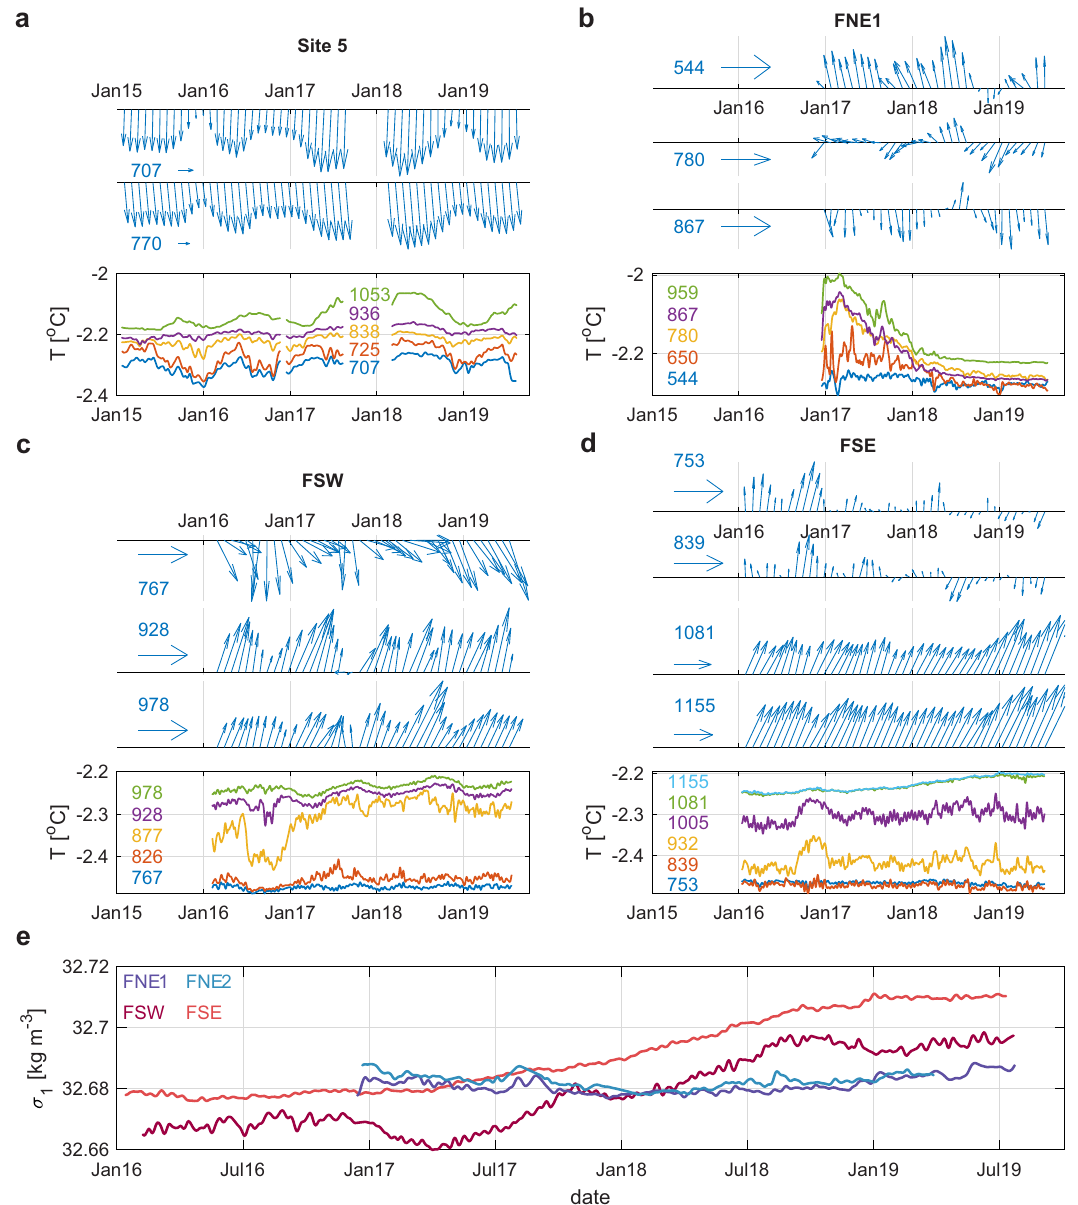
Fig. 4 Overview of ice shelf mooring observations. Time series of low-pass fi ltered velocity vectors (blue arrows) and in situ temperature (colored curves) at ( a ) Site 5, ( b ) FNE1, ( c ) FSW, and ( d ) FSE. Colored numbers indicate the instrument deployment pressure (dbar), horizontal arrows indicate an eastward current of 5 cm s − 1 as a reference scale for the respective axes. Time series ( e ) of potential density referenced to 1000 dbar from the lowermost sensors at the two northern and two southern drill sites on Filchner Ice Shelf showing the density reversal during the shift from Berkner mode to Ronne